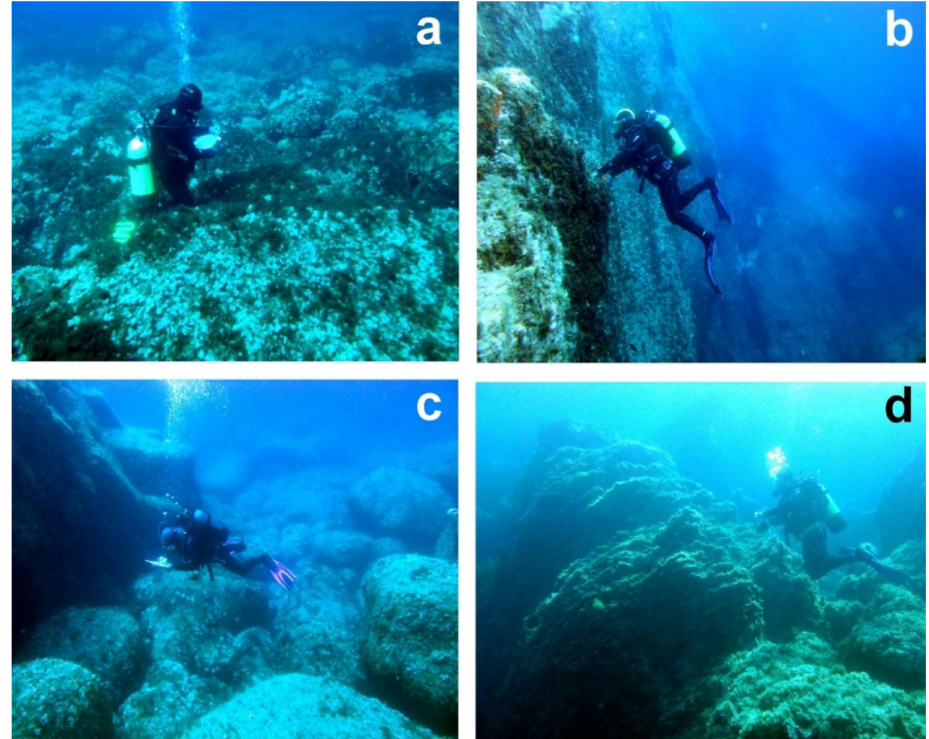
Figure 6. ( a ) Diver engaged in underwater geomorphological survey, using tablet with compass, clinometer, depth gauge and collimator at − 15; ( b ) Fault mirror exhumed by erosion in Cala Fico at 10 m; ( c ) Foot cliff deposit with subspheroidal blocks at − 18 m; ( d ) Lamination of pyroclastic lavas (Comenditi) in Cala Vinagra at 13